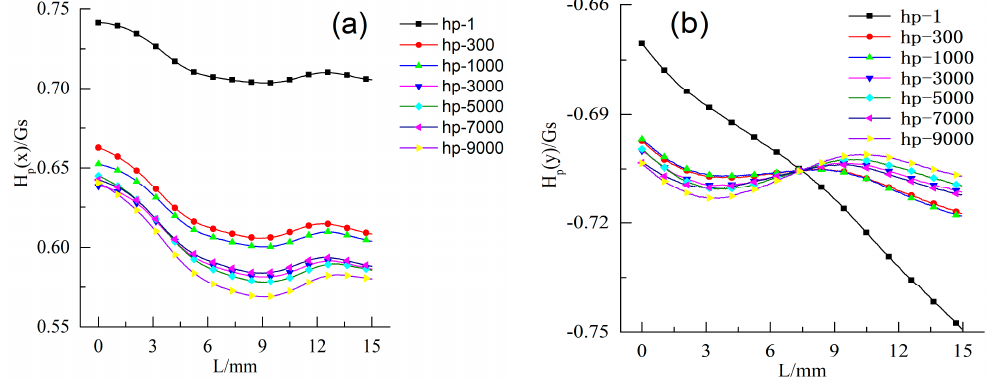
Figure 12. MMM signals of the specimen before crack propagation: ( a ) H p (x); and ( b ) H p (y).